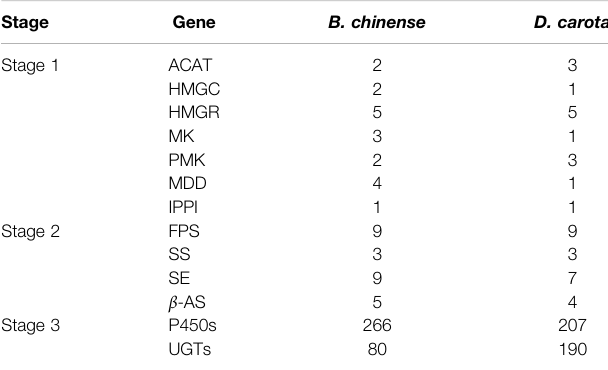
TABLE 2 | Genes involved in the biosynthesis of saikosaponins and their respective copy numbers in the B. chinense DC genome and D. carota